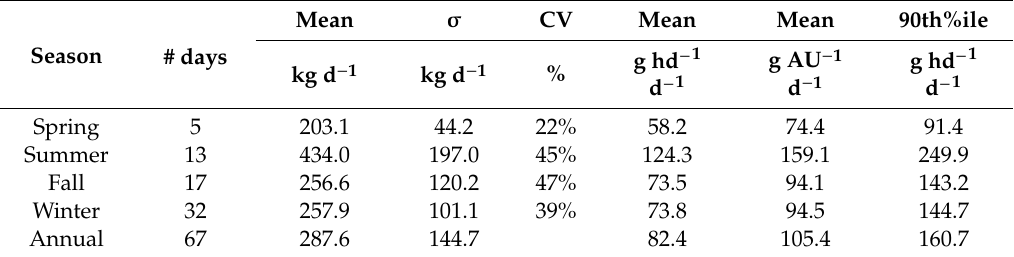
Table 6. Annual variation in whole-farm NH 3 emissions for representative